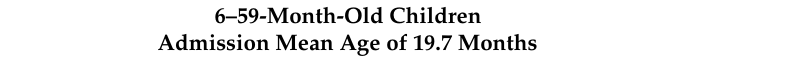
Table 5. Vitamin, mineral and inflammation status during the SAM effectiveness trial among children with (>50%) high